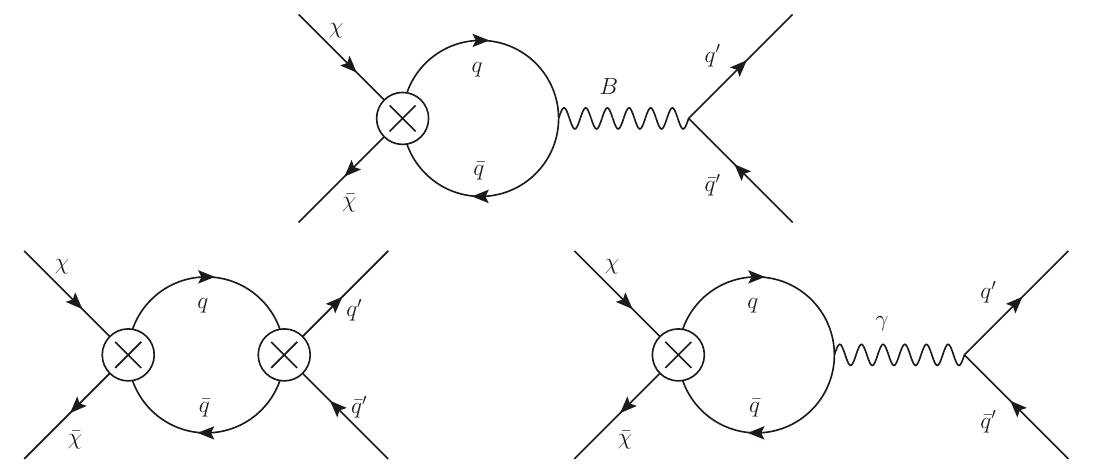
Figure 4 . The divergent loop diagrams responsible for mixing between the quark vector and axial vector currents ((cid:22) (cid:31) (cid:0) (cid:31) (cid:22) q (cid:0) q ) above the EW scale (top) and below (bottom). The most important aspect is the mixing of high-scale heavy quark currents q = c; t onto light quark vector currents q 0 = u; d , thus enabling a strong scattering cross section with